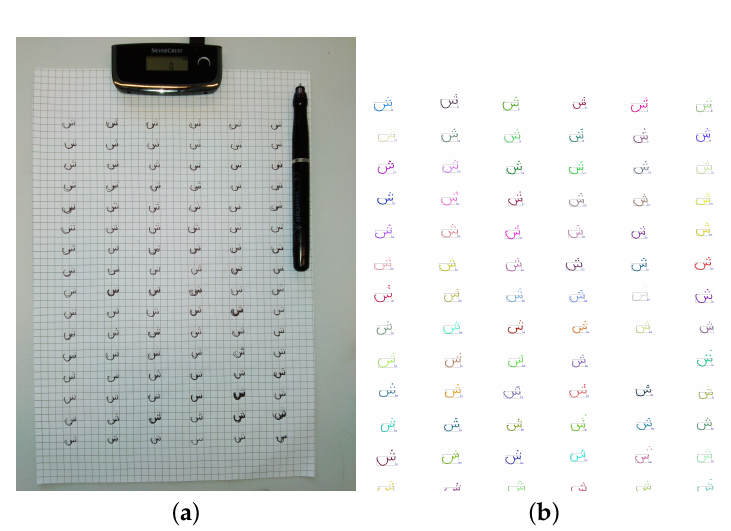
Figure 2. Online data acquisition. ( a ) Structure of data acquisition using the digital pen. ( b ) Visualization of the automatically extracted letter